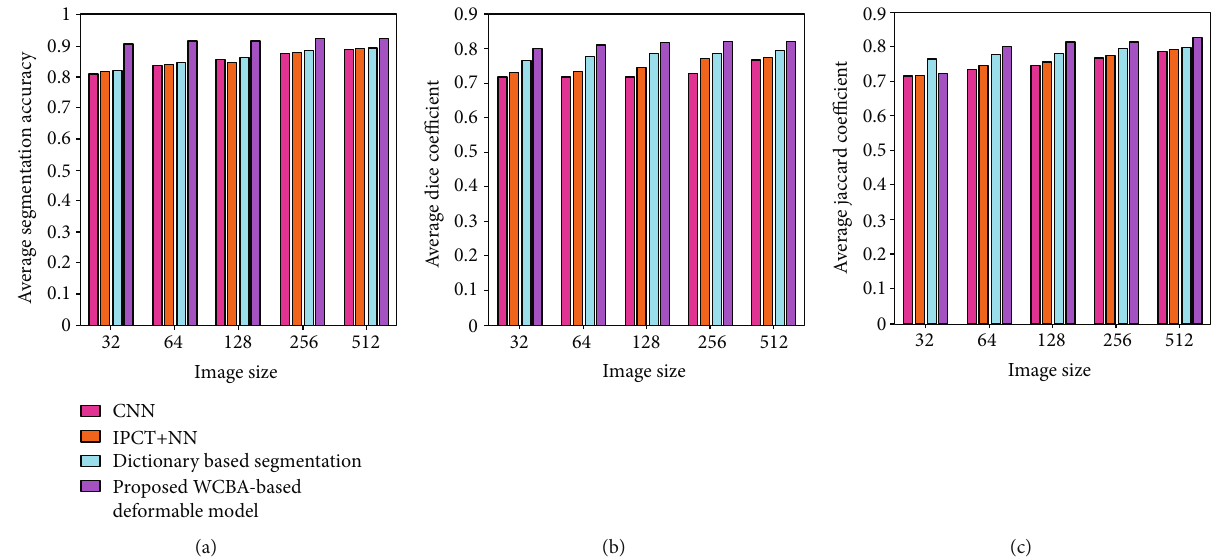
Figure 4: Comparative analysis of the proposed method for the cluster size 4: (a) average segmentation accuracy, (b) average Dice coe ffi cient, and (c) average Jaccard coe ffi cient.